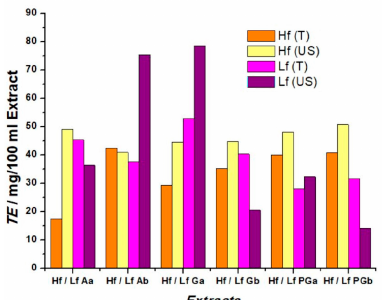
Figure 11. Histogram of CL determinations in terms of Trolox equivalent, for lavender and sea buckthorn extracts. Table 4. TE equivalent for some of the lavender and sea buckthorn extracts.